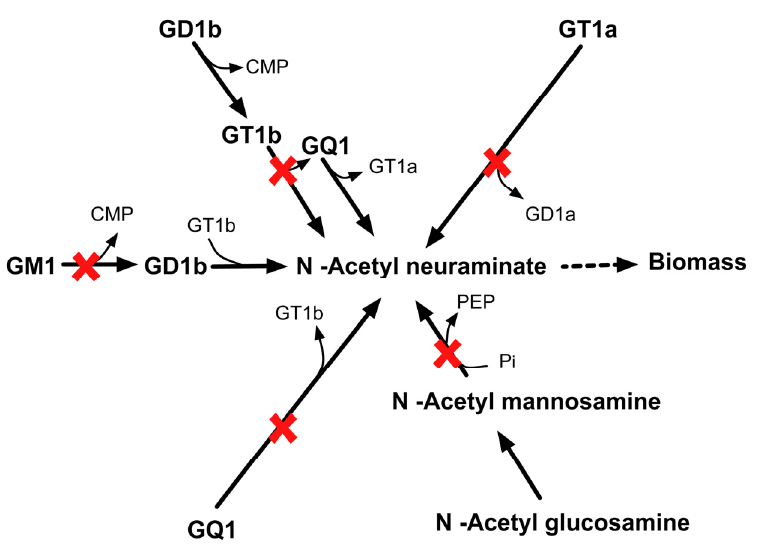
Figure 16. Lethality upon in silico removal of npl, nanS , st8Sia1 , and st8Sia5. The quadruple mutant is unable to synthesize biomass precursor N-acetyl